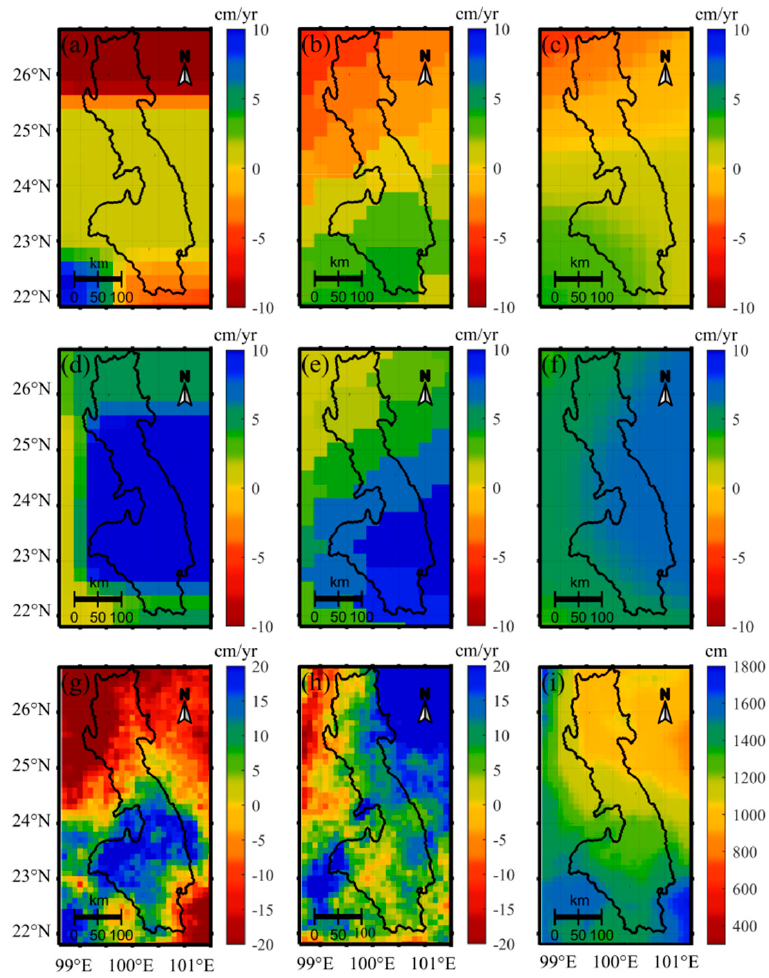
Figure 3. Spatial trends (first row: 2002–2009; second row: 2010–2019) of the total water storage anomaly (TWSA) derived from ( a – d ) JPL mascon, ( b – e ) CSR mascon, and ( c – f ) average spherical harmonics in the study region. Spatial information of precipitation (averaged from IMERG and CMAGrid) displayed as trends ( g ) 2002–2009, ( h ) 2010–2019, and annual average value ( i ) 2002–2019. The TWSA time series in the study region, as well as the Lancang River basin and Mekong River basin, derived from five GRACE solutions (Figure 4), are in agreement with the results shown in Figure 3. During the period from 2002 to 2009, the TWSA in the study region showed a slight upward trend, while exhibiting a particularly pronounced decline ( p < 0.05) in the Lancang ( − 2.21 cm/yr) and Mekong River basins ( − 8.65 cm/yr). From 2010 to 2019, the Mekong River basin’s TWSA decreased ( − 2.48 cm/yr), while both the study region (8.96 cm/yr) and the Lancang River basin (1.85 cm/yr) showed an